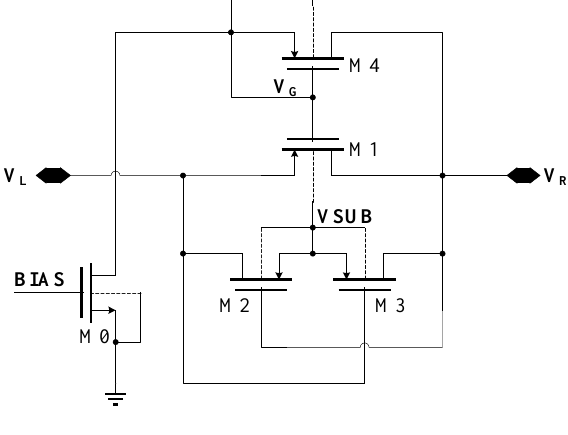
Figure 7. The schematic diagram of improved diode-connected